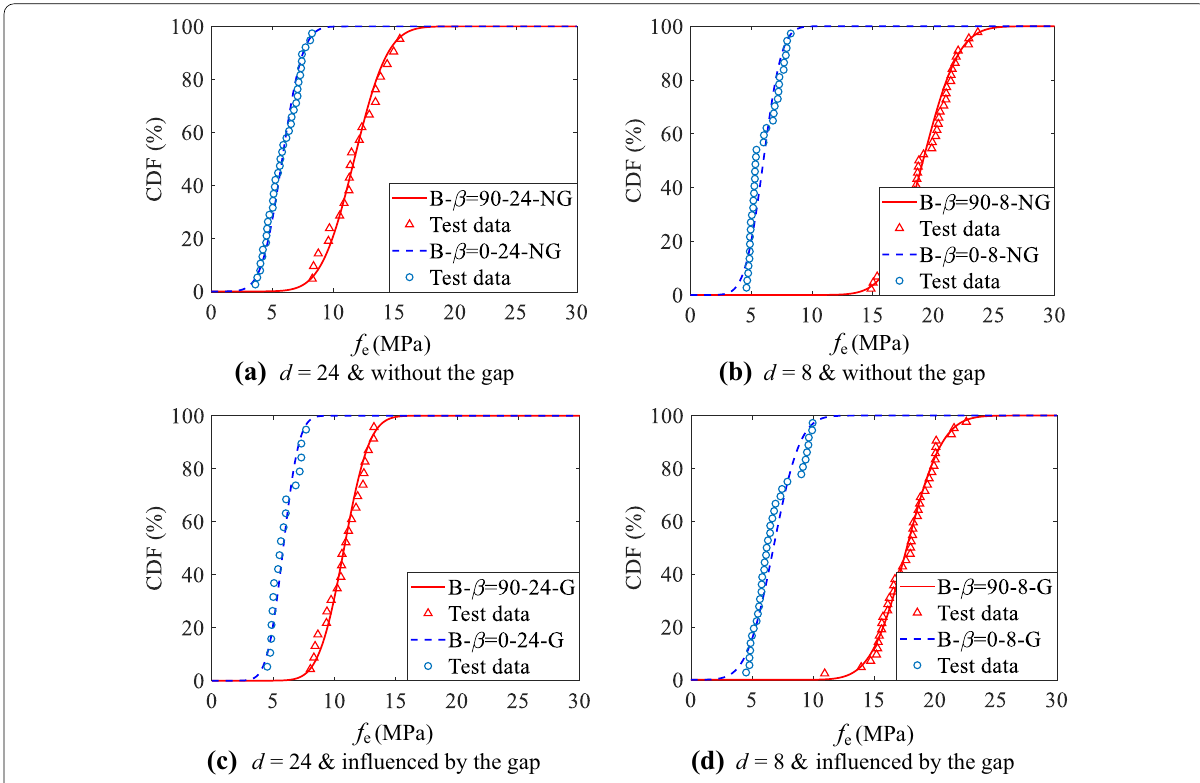
Fig. 15 Embedment strength of dowels with different embedment